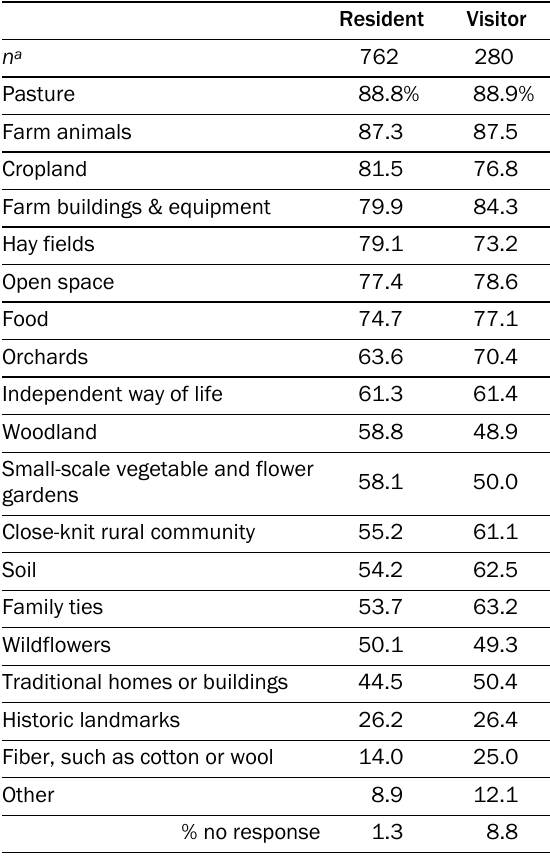
Table 3. Responses to the question, “When you think of farmland, what do you think